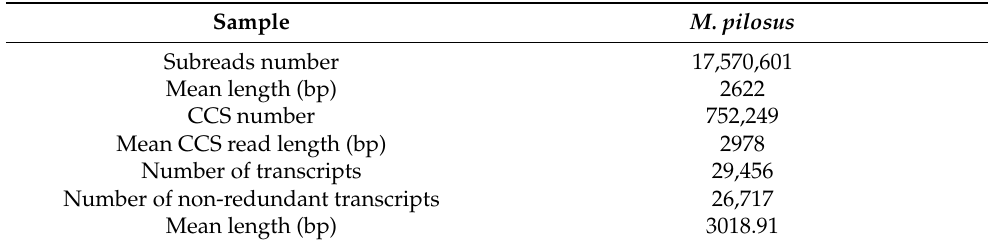
Table 1. Description of the transcriptome of M. pilosus by PacBio